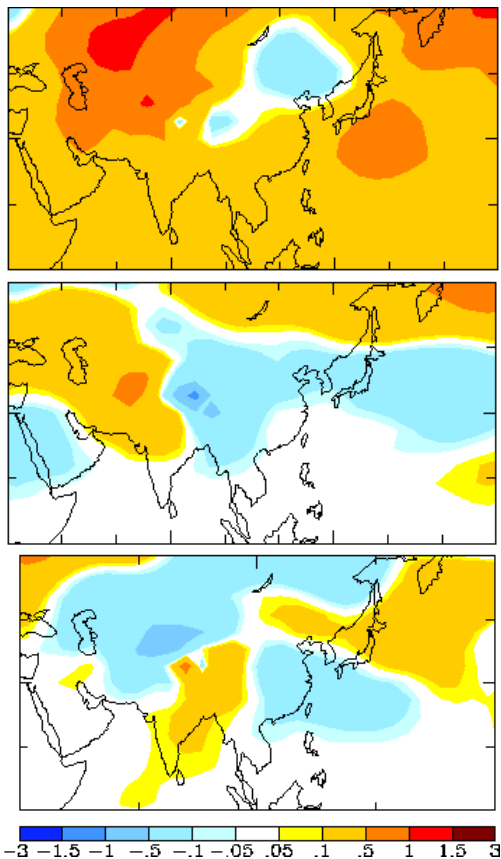
Fig. 7. Similar to Fig. 6 but for temperature at 630hPa. We use temperatures at 630hPa ( ∼ 4000m) that are indicative of surface temperatures for the high mountain ranges in the Himalayan-Hindu- Kush region that vary in height between 3 to 5km (Ramanathan et al.,